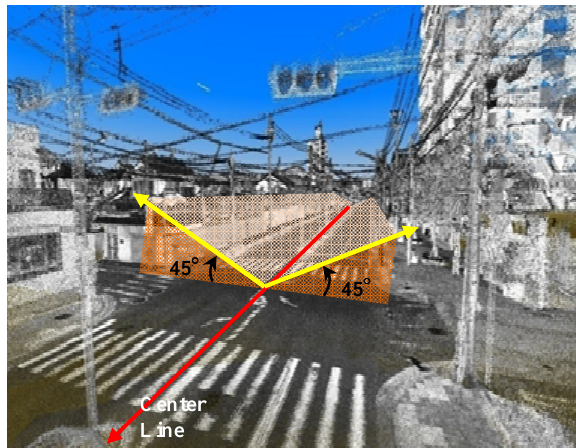
Figure.4 Measurement by high density laser 3D point group